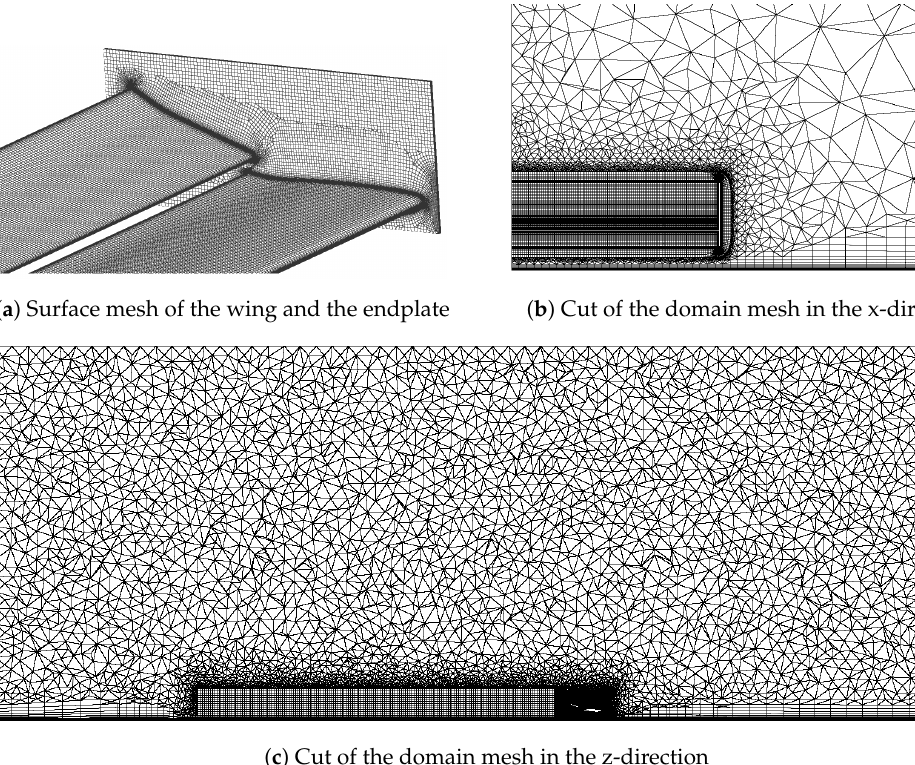
Figure 5. Overview of the domain